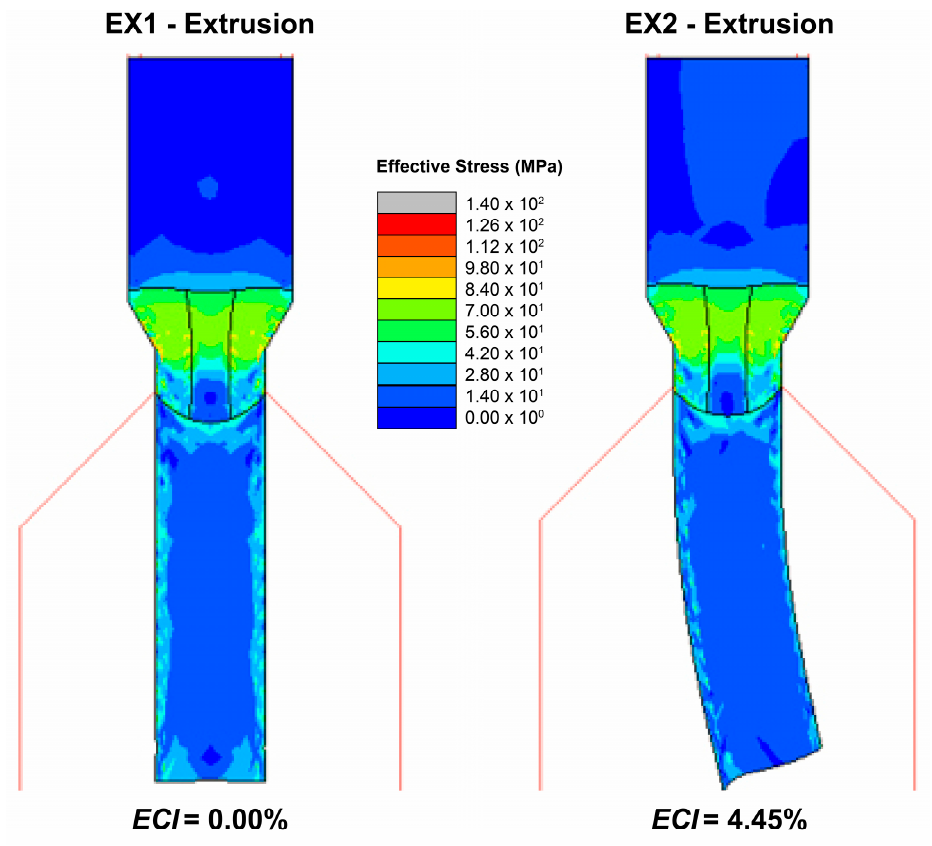
Figure 16. The micro-extrusion results comparison between the EX1 and EX2 conditions.